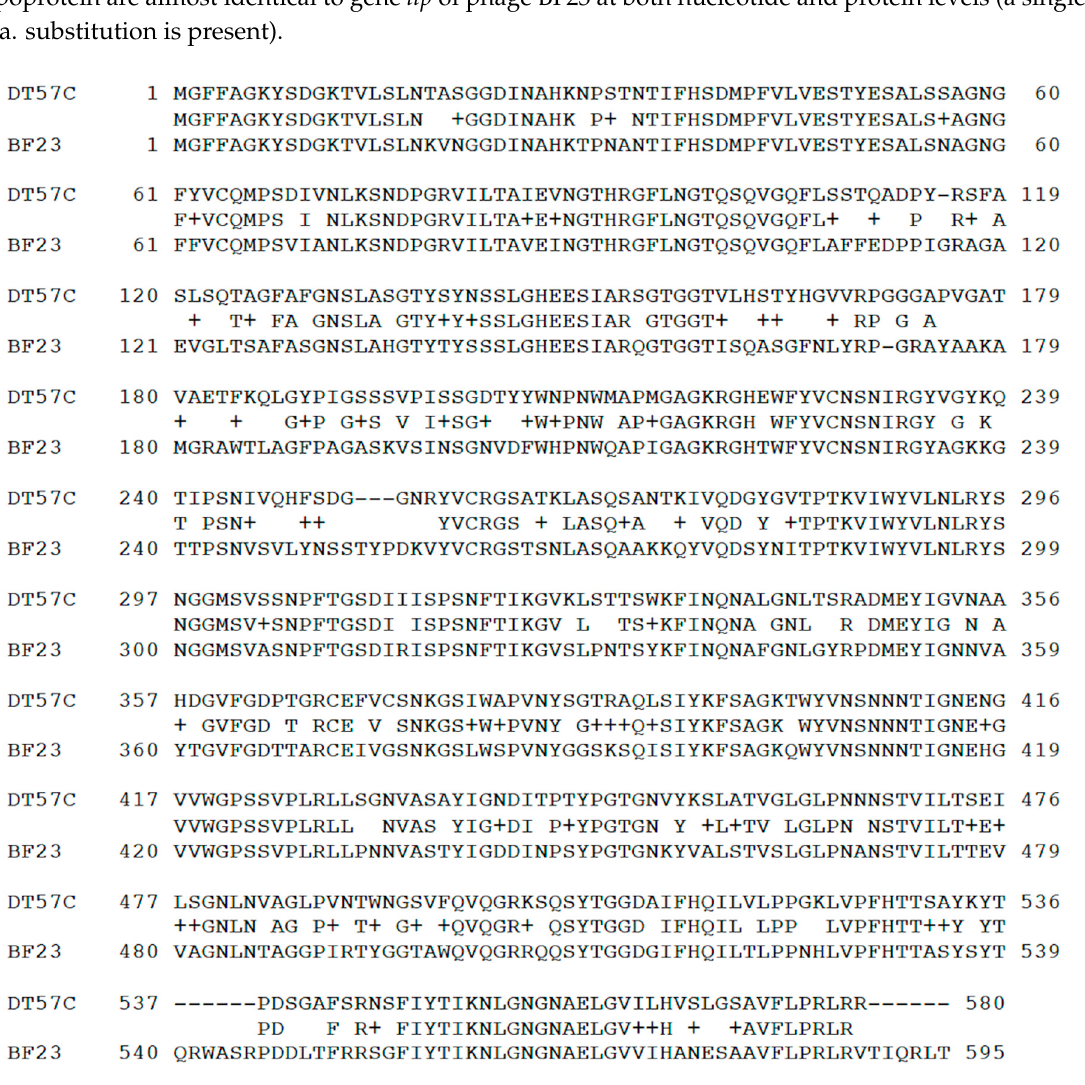
Figure 1. Alignment of Hrs protein (gp DT57C_000128) sequences of phage DT57C and phage BF23 Hrs (DT571/2 Hrs protein is identical to that of DT57C phage).